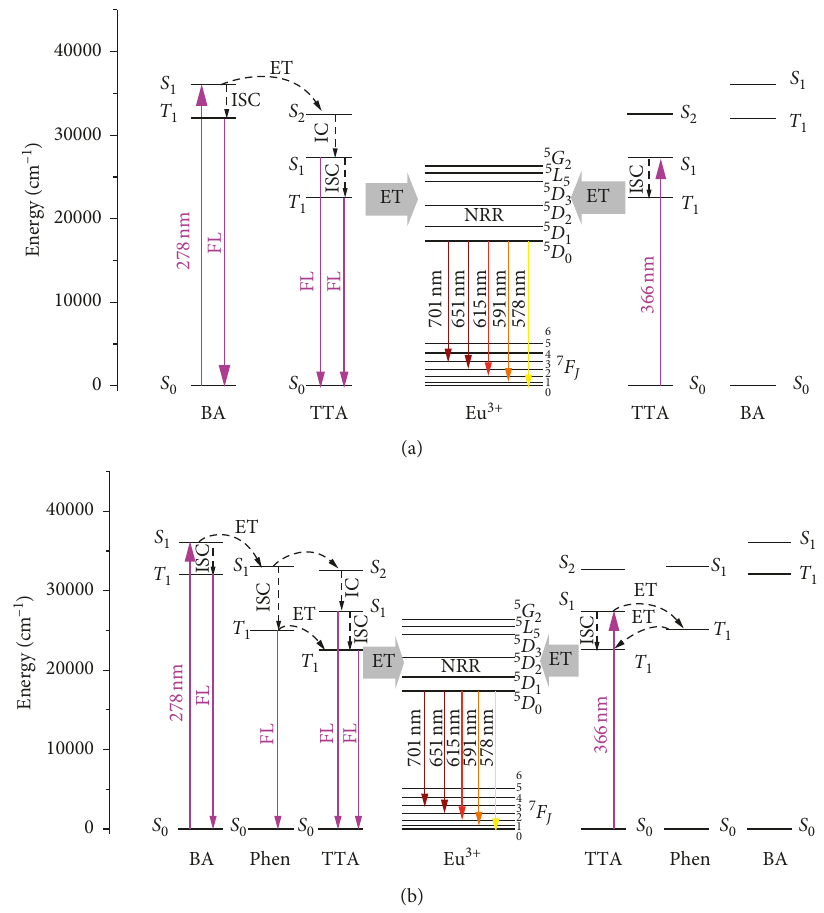
Figure 7: Schematic energy level diagram: energy transfer processes and different transitions in Eu(BA)(TTA) Eu(BA)(TTA) 2 Phen/PVP (b). ISC, intersystem crossing, IC, internal conversion, ET, energy transfer, S, singlet, T, triplet, and NRR, nonradiative